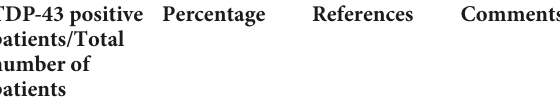
TABLE 1 Transactivation response element (TAR) DNA-binding protein 43 (TDP-43) positive immunoreactivity in Alzheimer’s disease (AD)